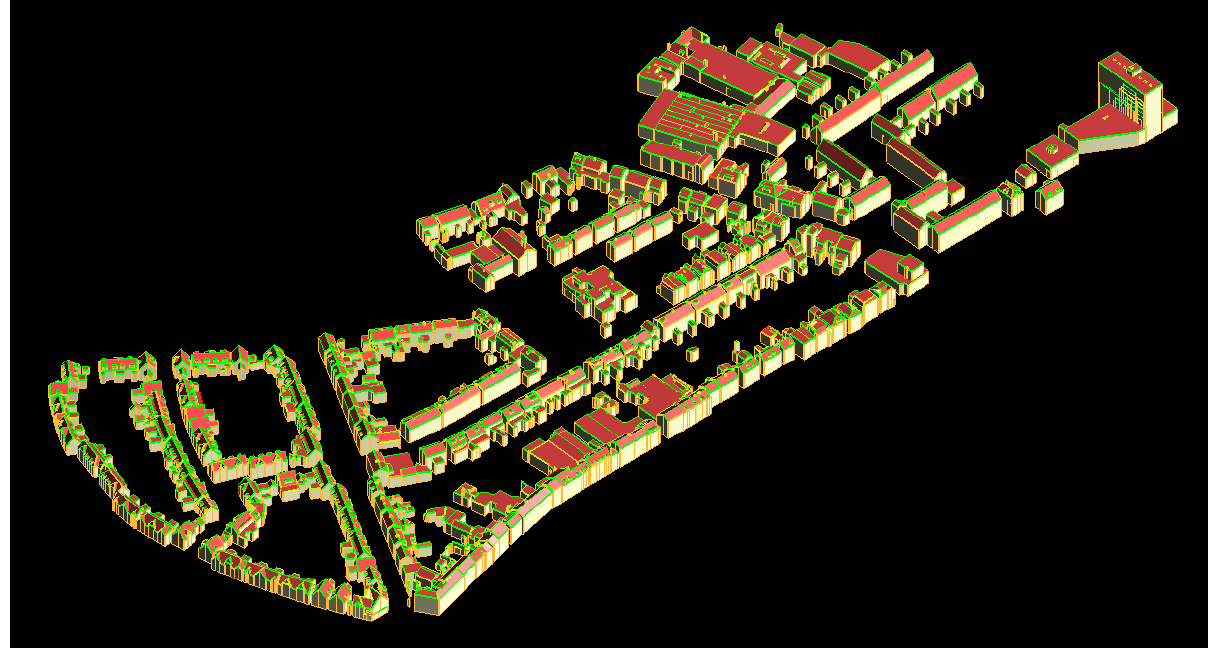
Figure 4. Reconstructed models in